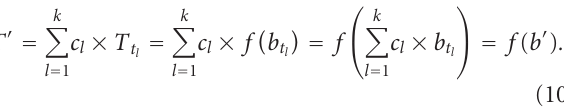
Figure 6: Repair phase: construction of new